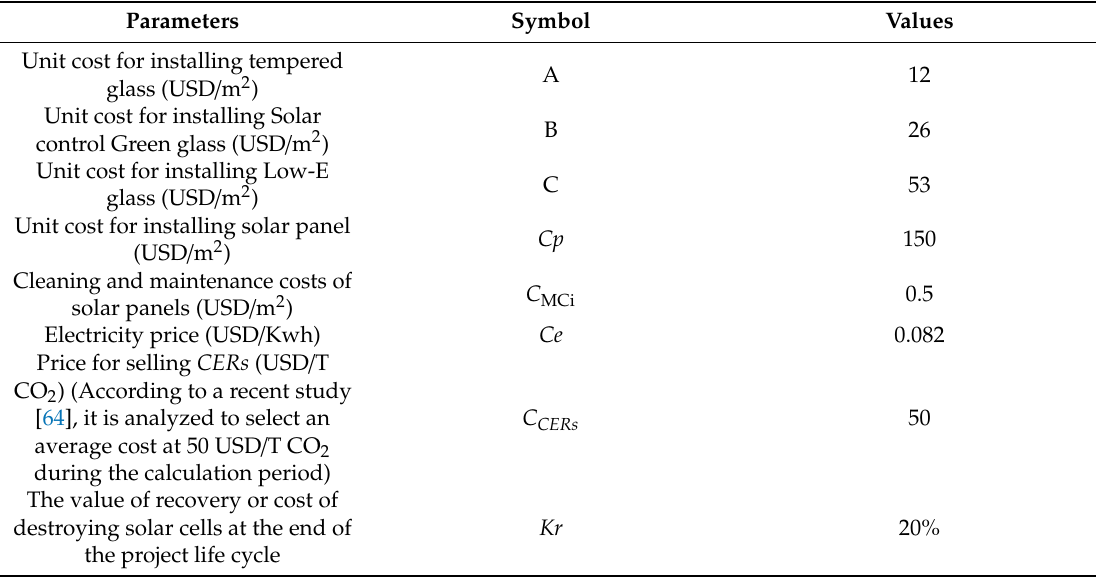
Table 6. Costs in economic analysis.